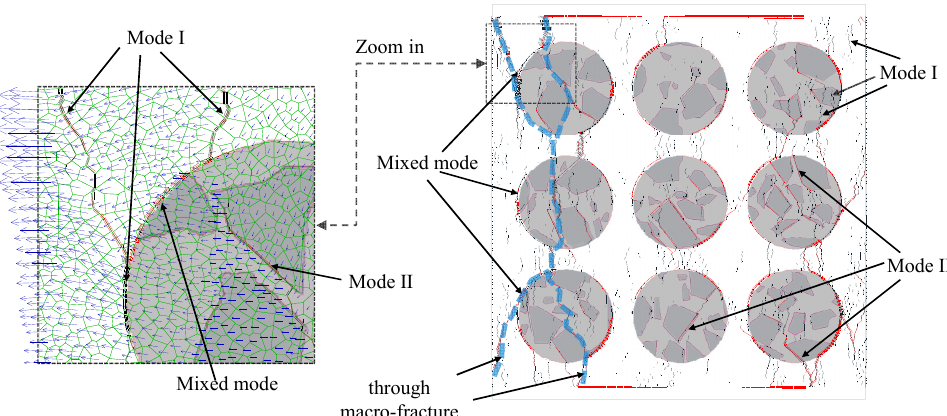
Figure 19. Enlarged view of crack distribution at stage d (peak loading stage).